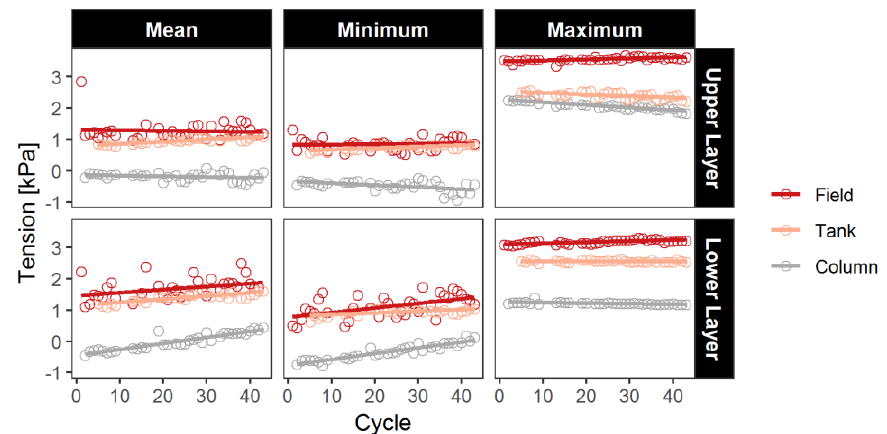
Figure 3. Calculation of mean and minimum tension values during the wet phase and maximum tension values during the dry phase for every cycle of scenario 2.